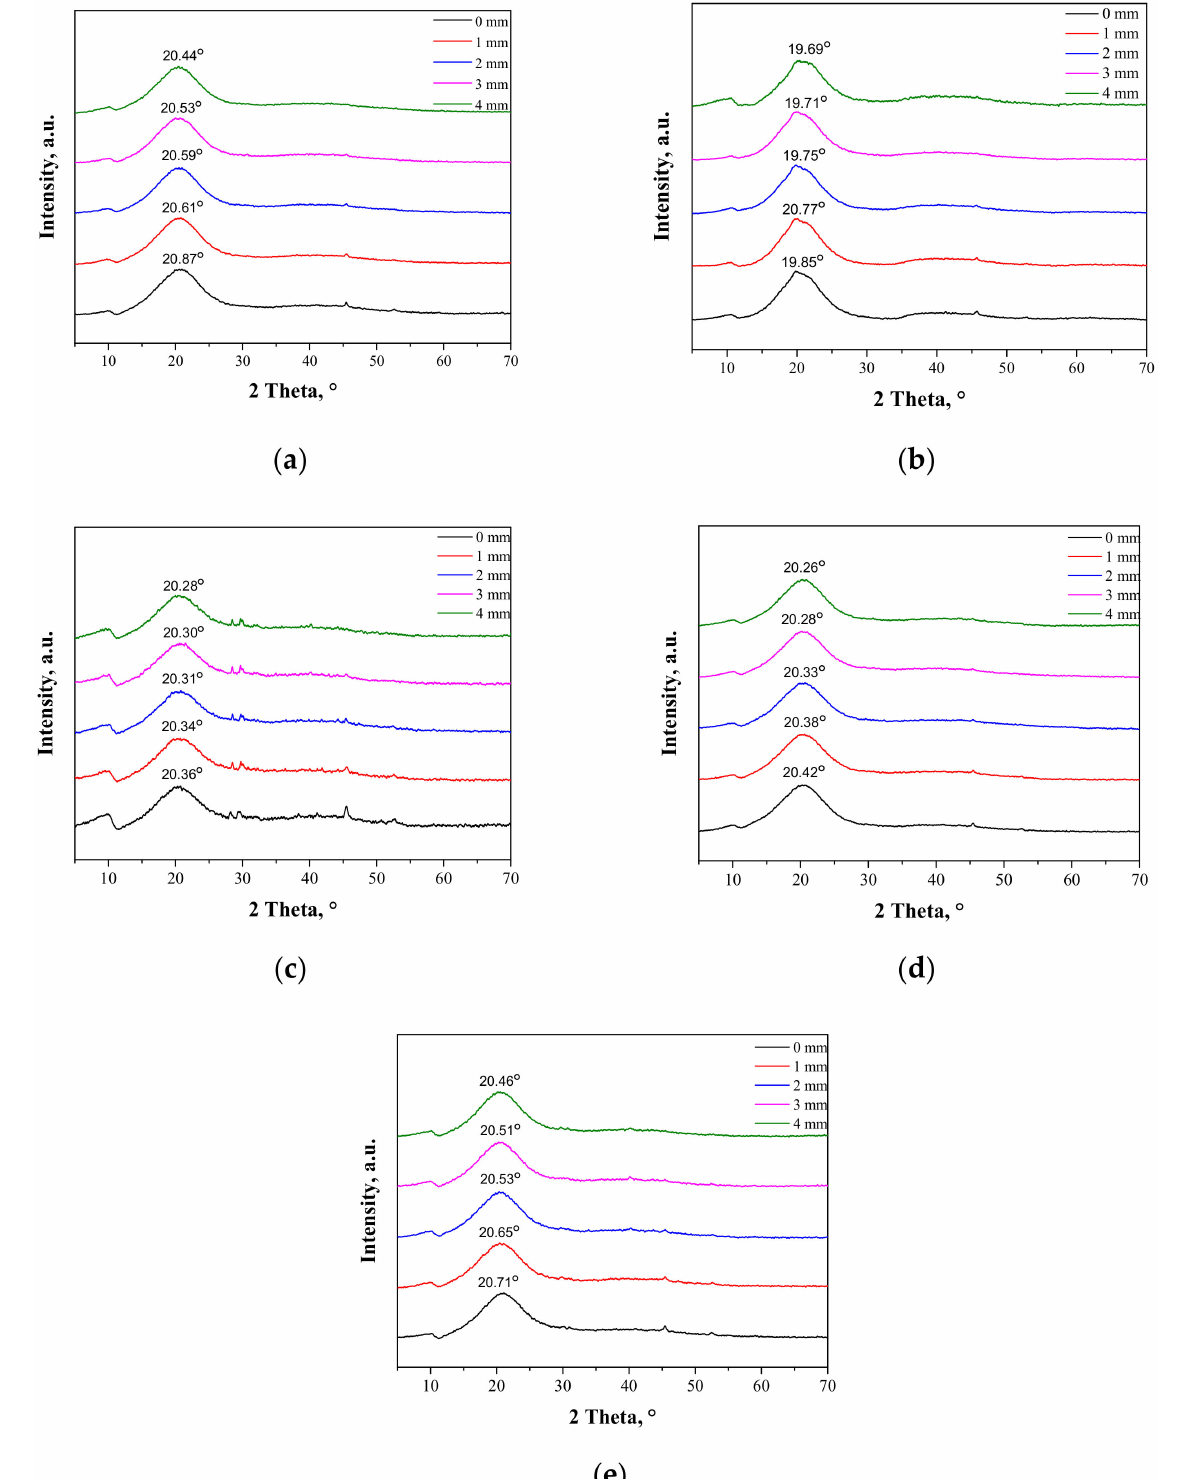
Figure 5. XRD patterns of sample 0/0 ( a ); sample 2.5/4.0 ( b ); sample 5.0/4.0 ( c ); sample 2.5/8.0 ( d ); and sample 5.0/8.0 ( e ) subjected to the tensile